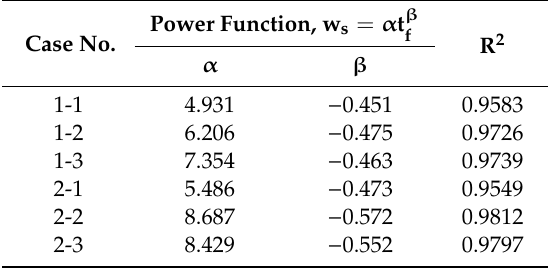
Table 2. Optimal parameter values of the power function fit to the data sets. Case